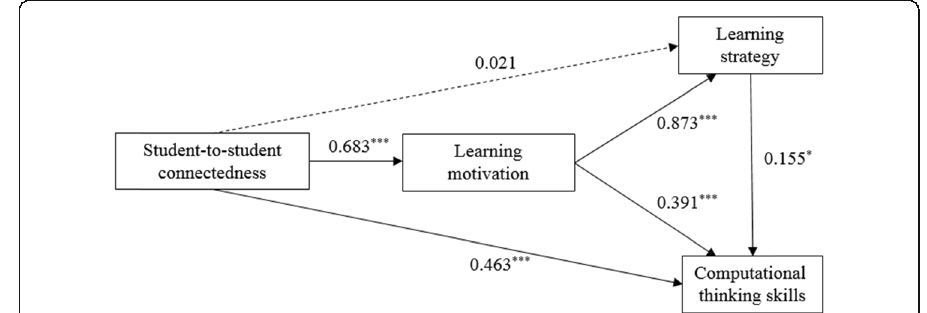
Fig. 2 Structural model of computational thinking